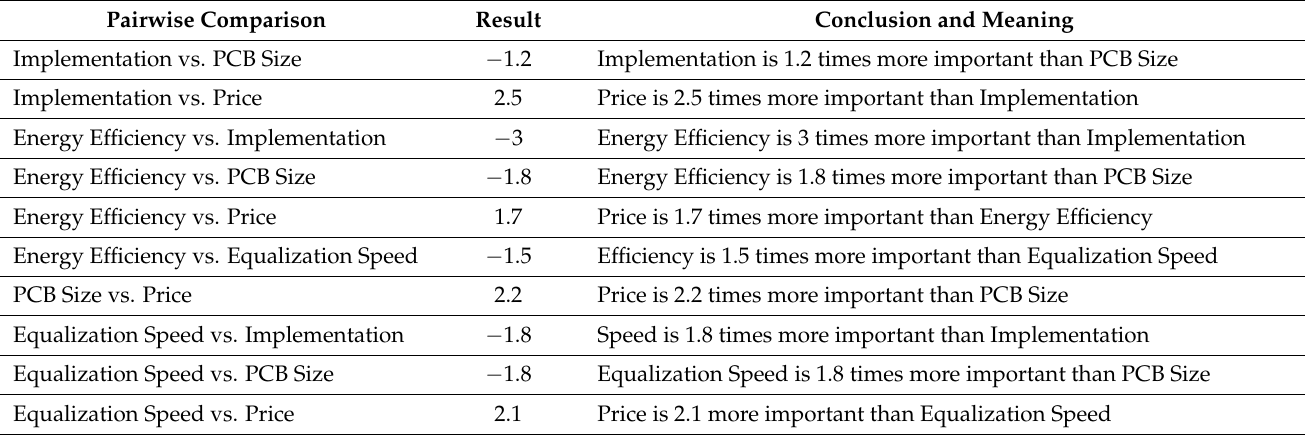
Table 4. Survey result for the numerical scale for pairwise comparisons.